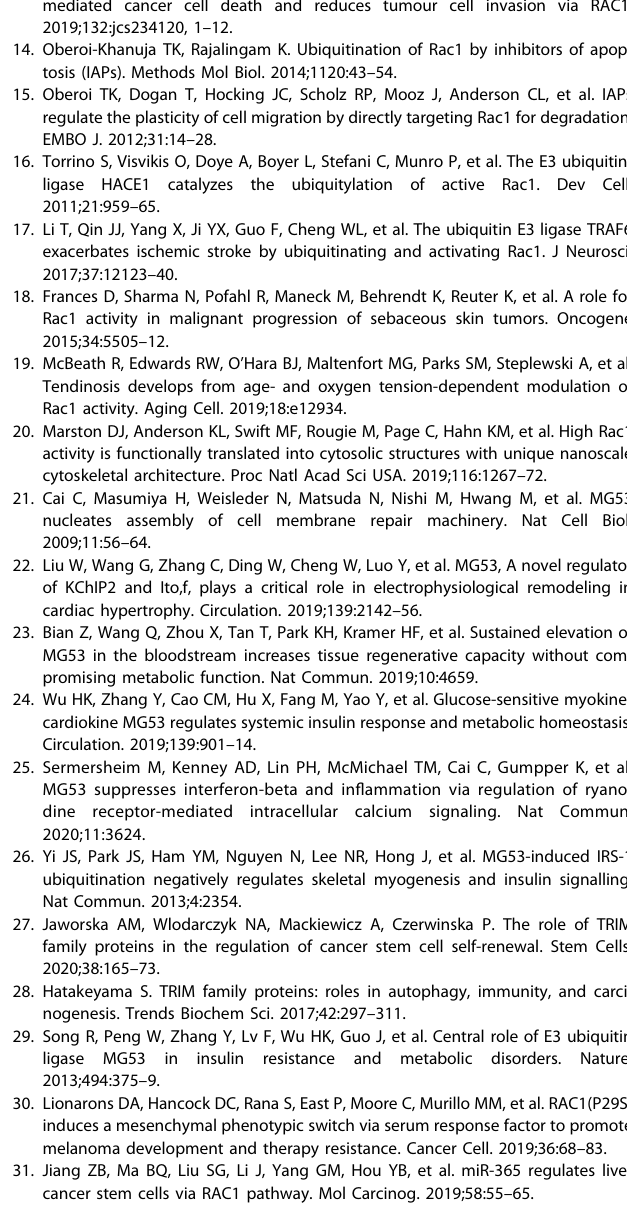
Fig. 6 Exogenous overexpression of MG53 inhibited the hepatocarcinogenesis in vivo. To construct xenograft tumor model, 0.1 ml of 10 7 HUH7 cells were subcutaneously injected to both fl anks of the nude mice (4-week-old male BALB/c nude mice, n = 8). When visible tumors appeared, the tumors at the left fl anks were injected with Myc-MG53 plasmid while tumors at the right fl anks were injected with Myc-vector plasmid. The mice were sacri fi ced on day 26 after the fi rst injection, and the tumors were separated from both fl anks of the mice for further analysis. A , B The tumor growth curve ( A ) and the image of the isolated tumors from sacri fi ced mice ( B ) were presented. C , D The tumor volumes ( C ) and tumor weights ( D ) of the indicated groups were analyzed and compared. E qRT-PCR was performed to detect the relative MG53 expression level in MG53 and mock plasmid transfected group. F Protein extracted from the tumors was used for western blot assay to detect the expression levels of Myc, RAC1, p-JNK, p-P38 and p-ERK. G – J Another group of xenograft tumor model was constructed as the above described (4-week-old male BALB/c nude mice, n = 5 for indicated group). When visible tumors appeared, the tumors were divided into three groups including Myc-vector transfected group, Myc-MG53 transfected group and Myc-MG53- Δ RING transfected group. The tumors were injected with 20 μ g of indicated plasmids every other day. The mice were sacri fi ced on day 28 after the fi rst injection, and the tumors were separated from the nude mice for further analysis. The image of the isolated tumors from sacri fi ced mice was presented ( G ). H – J Western blot was performed to detect the successful transfection of the indicated groups ( H ). Tumor volumes ( I ) and tumor weights ( J ) of the indicated groups were analyzed and compared. K The working model showing the role and mechanism of MG53 in HCC cells. MG53 directly binds with RAC1 through its coiled-coil domain and further induces ubiquitous degradation of RAC1 by K48 linked poly-ubiquitination, which leads to inhibition of the RAC1-MAPK pathway; and fi nally reverses the malignant behaviors of HCC cells and enhances the chemosensitivity of HCC cells to sorafenib. * P < 0.05, ** P < 0.01 and *** P < 0.001 for statistical analysis of the indicated